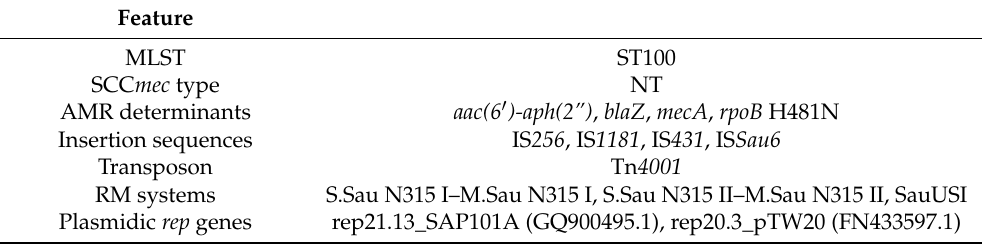
Table 3. Summary of genomic features shared by all strains. Genotypic features (MLST and SCC mec type), and the presence of full/complete genetic determinants (mobile genetic elements, antimicrobial resistance and restriction modification systems) detected in the genomes included in this study.